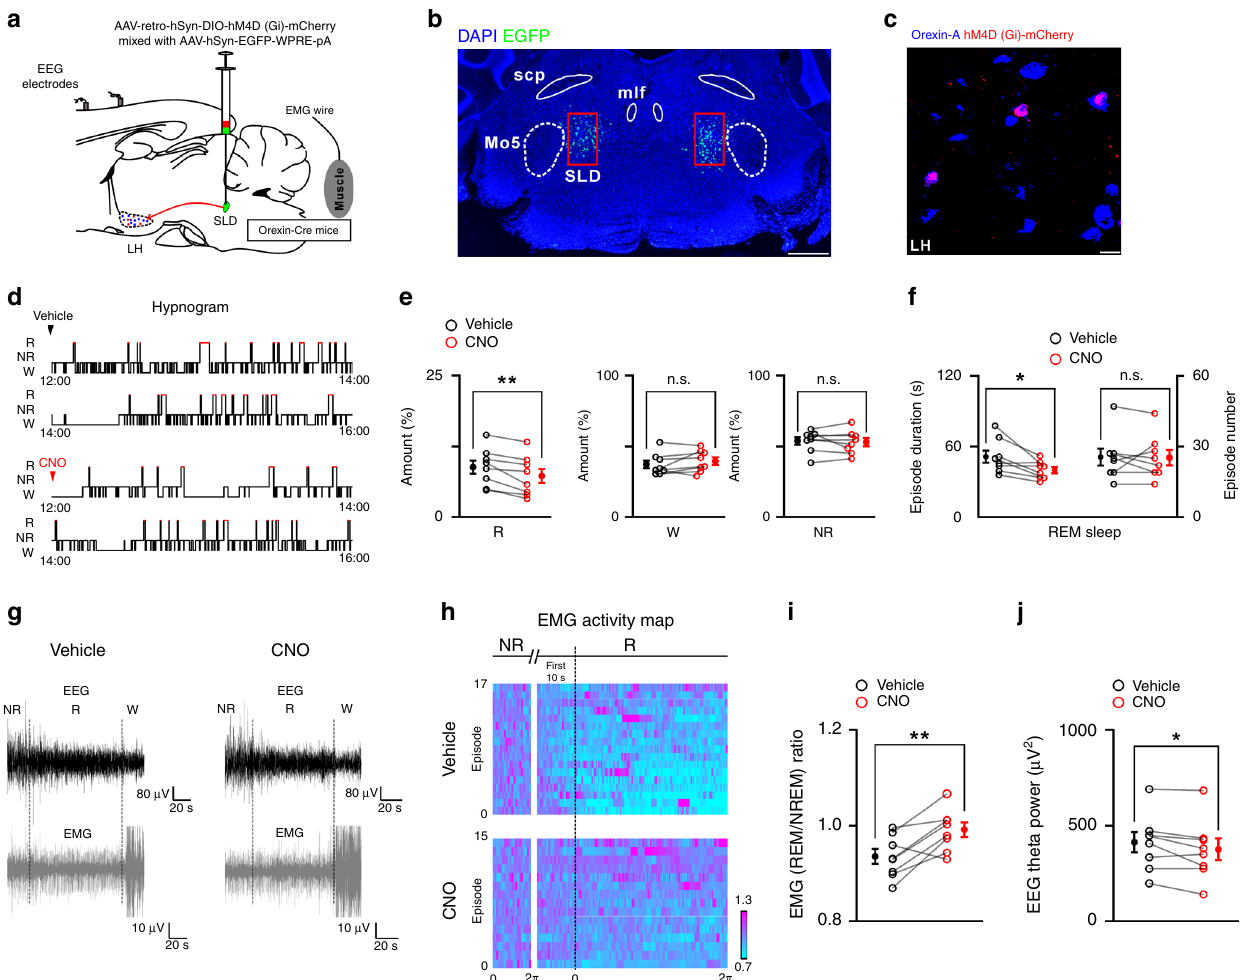
Fig. 8 Chemogenetic silencing of SLD orexin signaling destabilizes REM sleep. a Schematic drawing for chemogenetic silencing of SLD orexin signaling. b Representative virus injection sites in the SLD (scale bar: 500 μ m). mlf medial longitudinal fasciculus. c Representative expression of hM4D (Gi)- mCherry (red) in the orexin-A + (blue) neurons. Scale bar: 20 μ m. d Hypnogram showing the sleep/wakefulness states in the following 4 h after vehicle and CNO injections in a tested orexin SLD-hM4D mouse. e The amount of REM sleep (two-sided paired t -test; t 7 = 3.865, P = 6.170 × 10 − 3 ), wakefulness (two- sided paired t -test; t 7 = 1.355, P = 0.217), and NREM sleep (two-sided paired t -test; t 7 = 0.527, P = 0.615) during the 4-h recording period after CNO and vehicle injections ( n = 8 orexin SLD-hM4D mice). f The episode duration (left, two-sided paired t -test; t 7 = 2.789, P = 0.0269) and number (right, two-sided paired t -test; t 7 = 0, P = 1.000) of REM sleep during the 4-h recording period after CNO and vehicle injections ( n = 8 orexin SLD-hM4D mice).